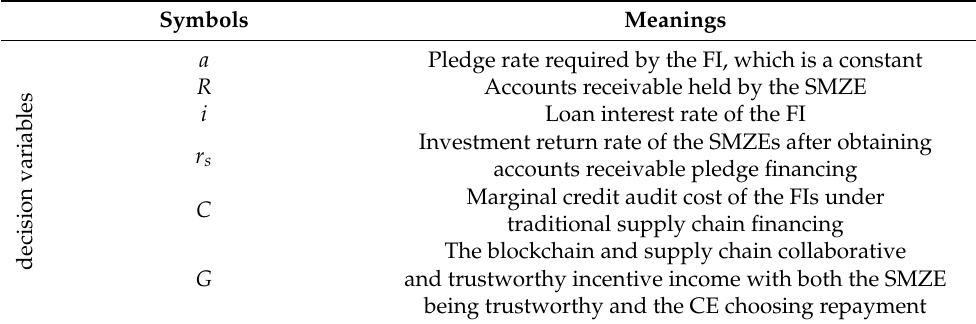
Table 1. The parameter symbols and their meanings.